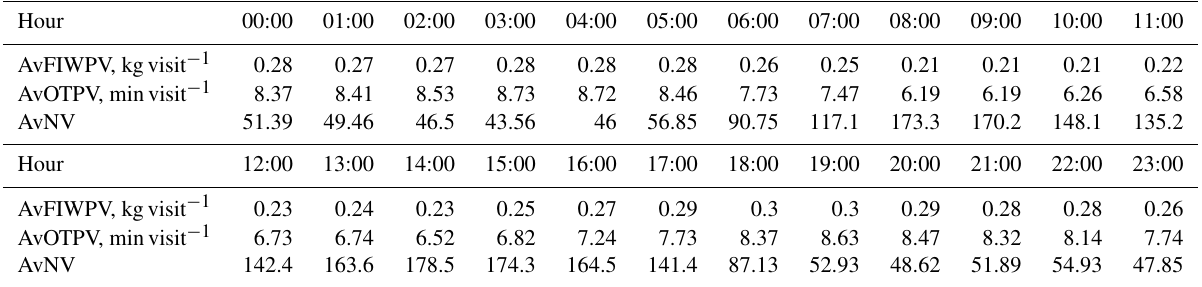
Table 2. Interview of traits at each hour.